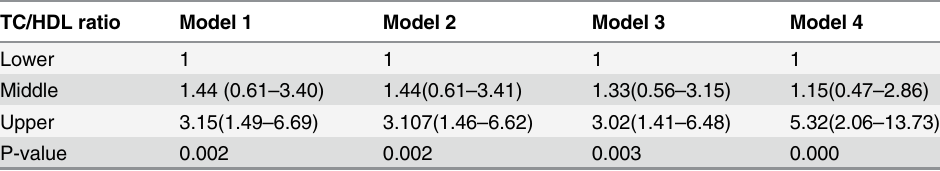
Table 2. HRs for all-cause mortality according to TG/HDL-C